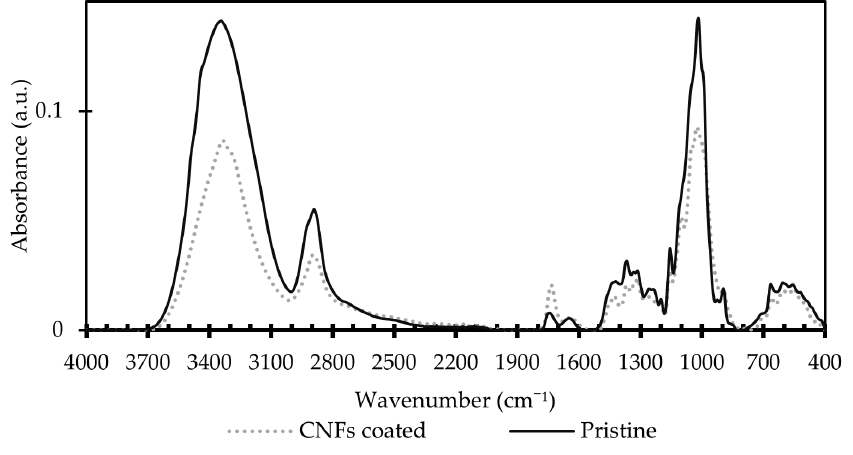
Figure 3. FTIR spectra of the pristine RC70PP and coated with 6.5 g/m 2 of CNF membranes.